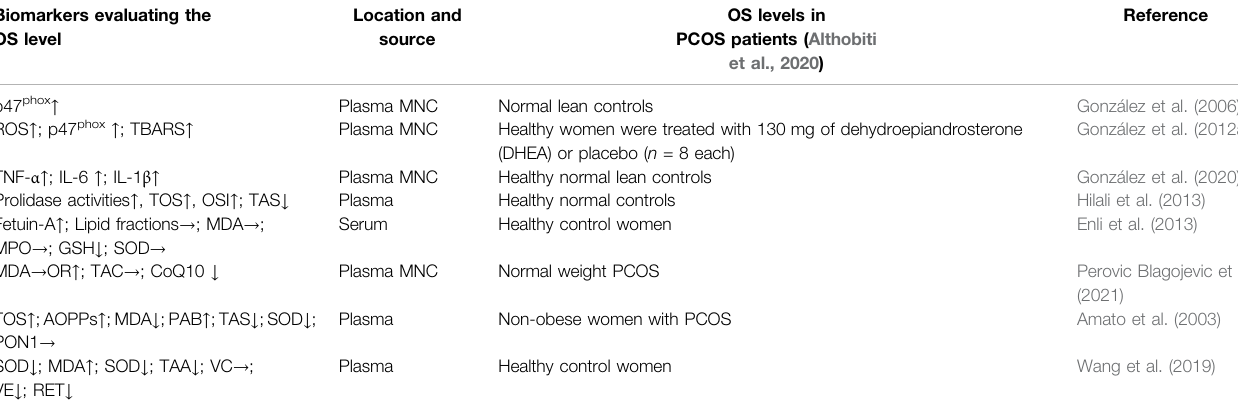
TABLE 1 | Oxidative stress (OS) markers of women with polycystic ovary syndrome (PCOS). Biomarkers evaluating the OS